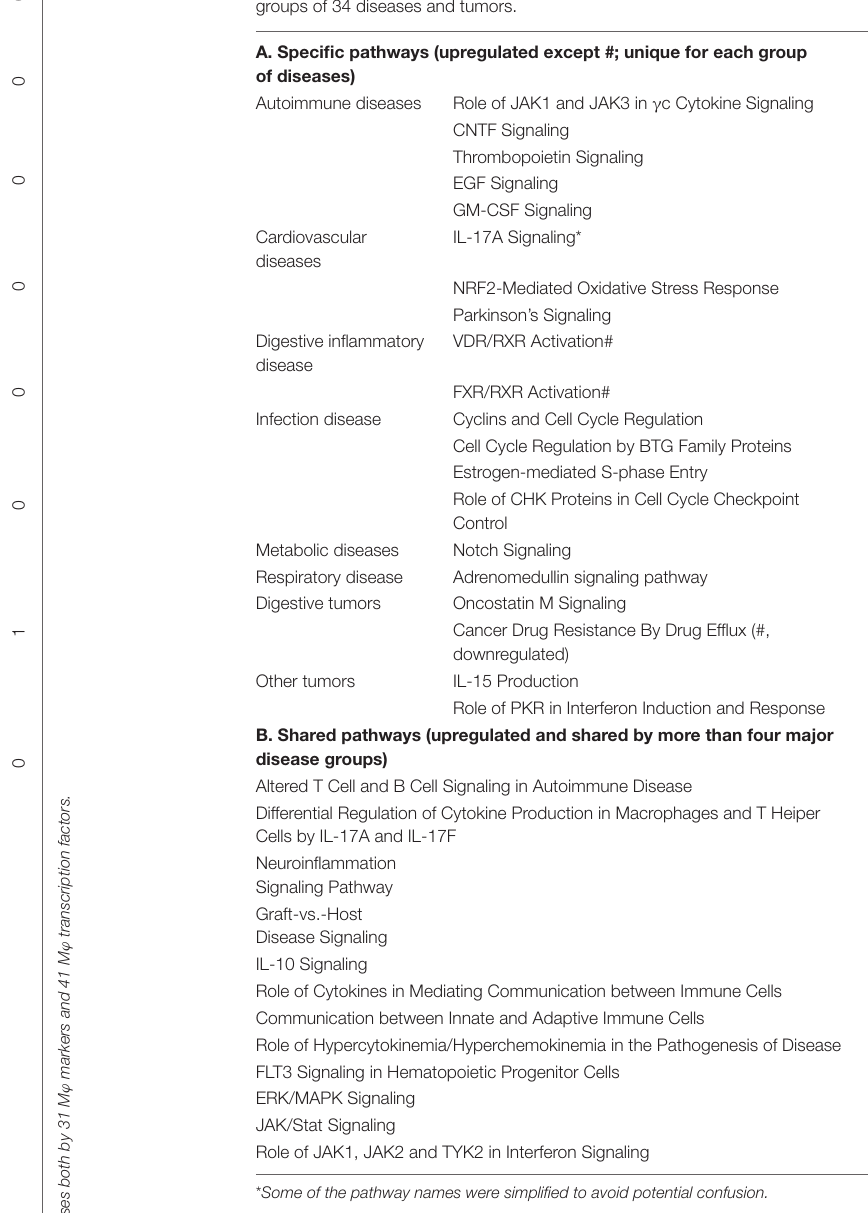
TABLE 3E | Twenty new disease group-specific and 12 shared (more than 4 groups of diseases) M ϕ reprogramming pathways have been identified in eight groups of 34 diseases and